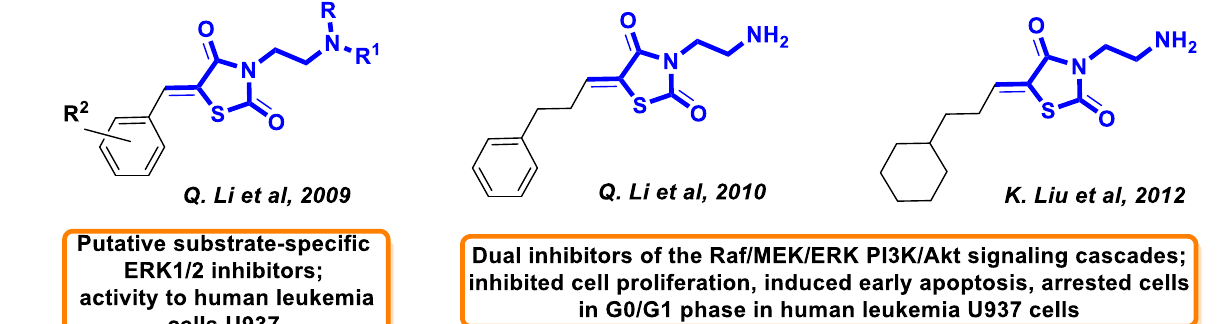
Figure 1. Background for the present research [8 – 10].